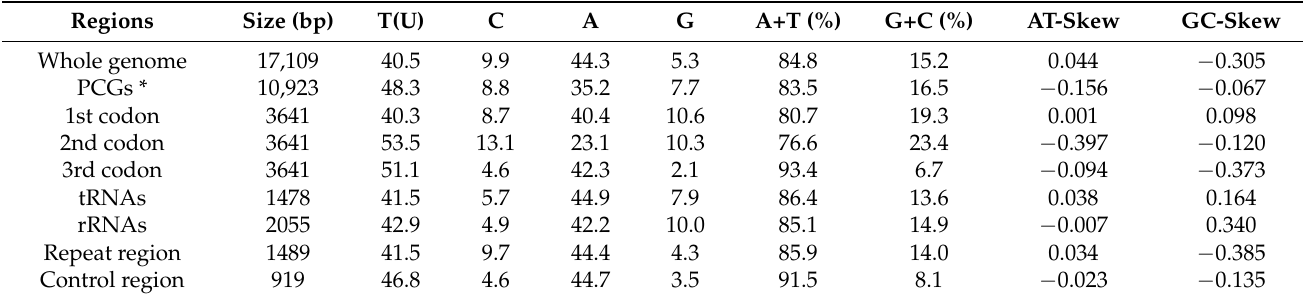
Table 3. Nucleotide composition of the Stomaphis sinisalicis mitogenome.